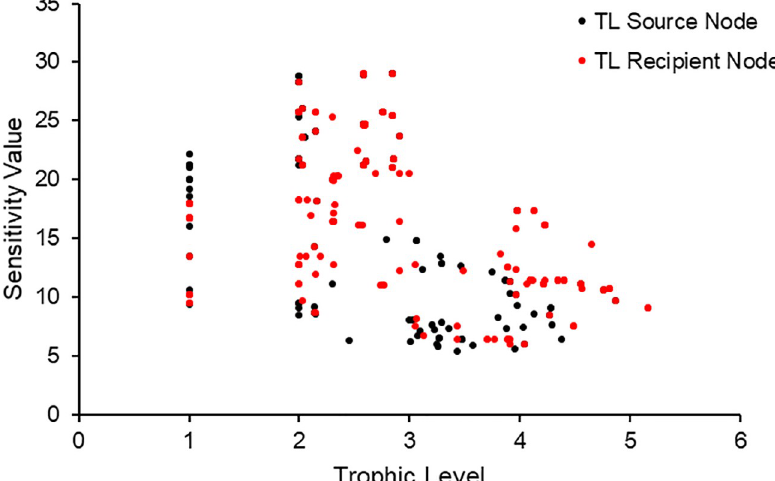
Fig 5. Sensitivity values of flows (calculated using Eq 10) are plotted against the effective trophic level of both the source and recipient compartment.